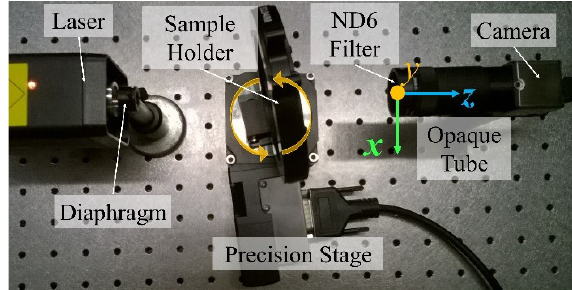
Fig. 2. Final system setup with an HeNe laser (632.8 nm), automatic 1-axis rotation stage and CMOS camera.